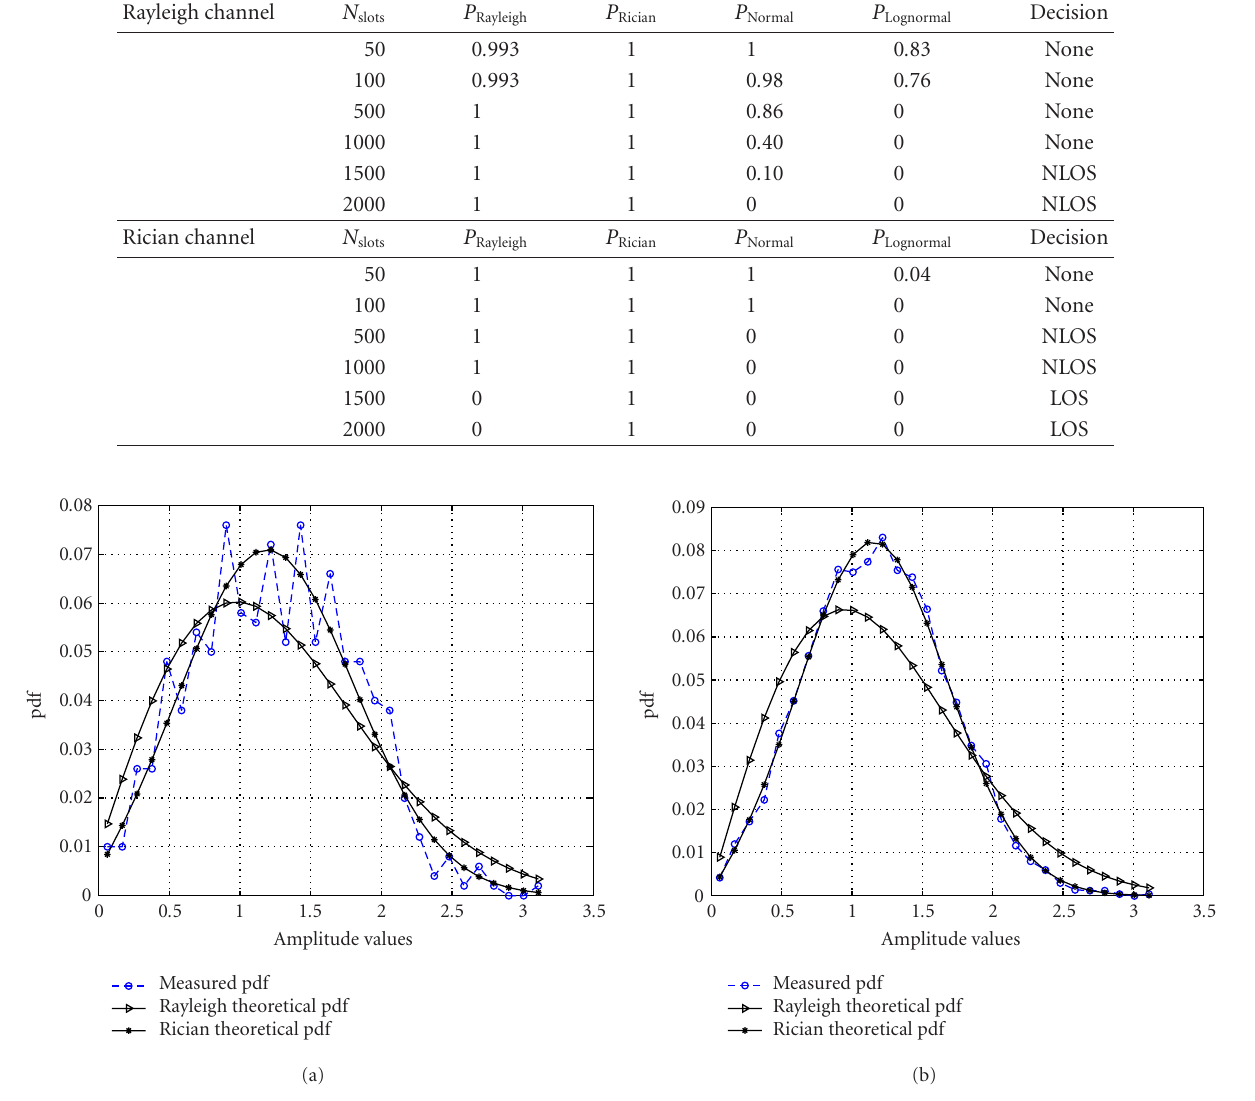
Table 1: Probabilities of accepting a certain distribution with a confidence level of 99 . 99%. Rayleigh and Rician channels ( K r = 15 . 5dB) and v = 22 . 22m/s.